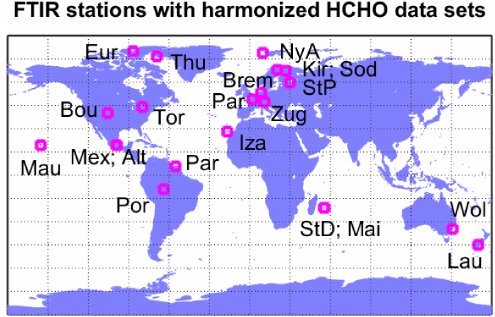
Figure 1. Locations of the FTIR stations providing HCHO total